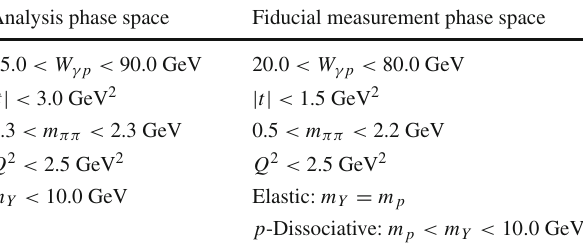
Table 3 Analysis and fiducial measurement phase space. At detector level, the respective cuts are applied to W rec γ p , t rec , and m rec ππ , the Q 2 cut is replaced by the veto on the reconstruction of the scattered electron, and the m Y cut is replaced by the rapidity gap requirement as